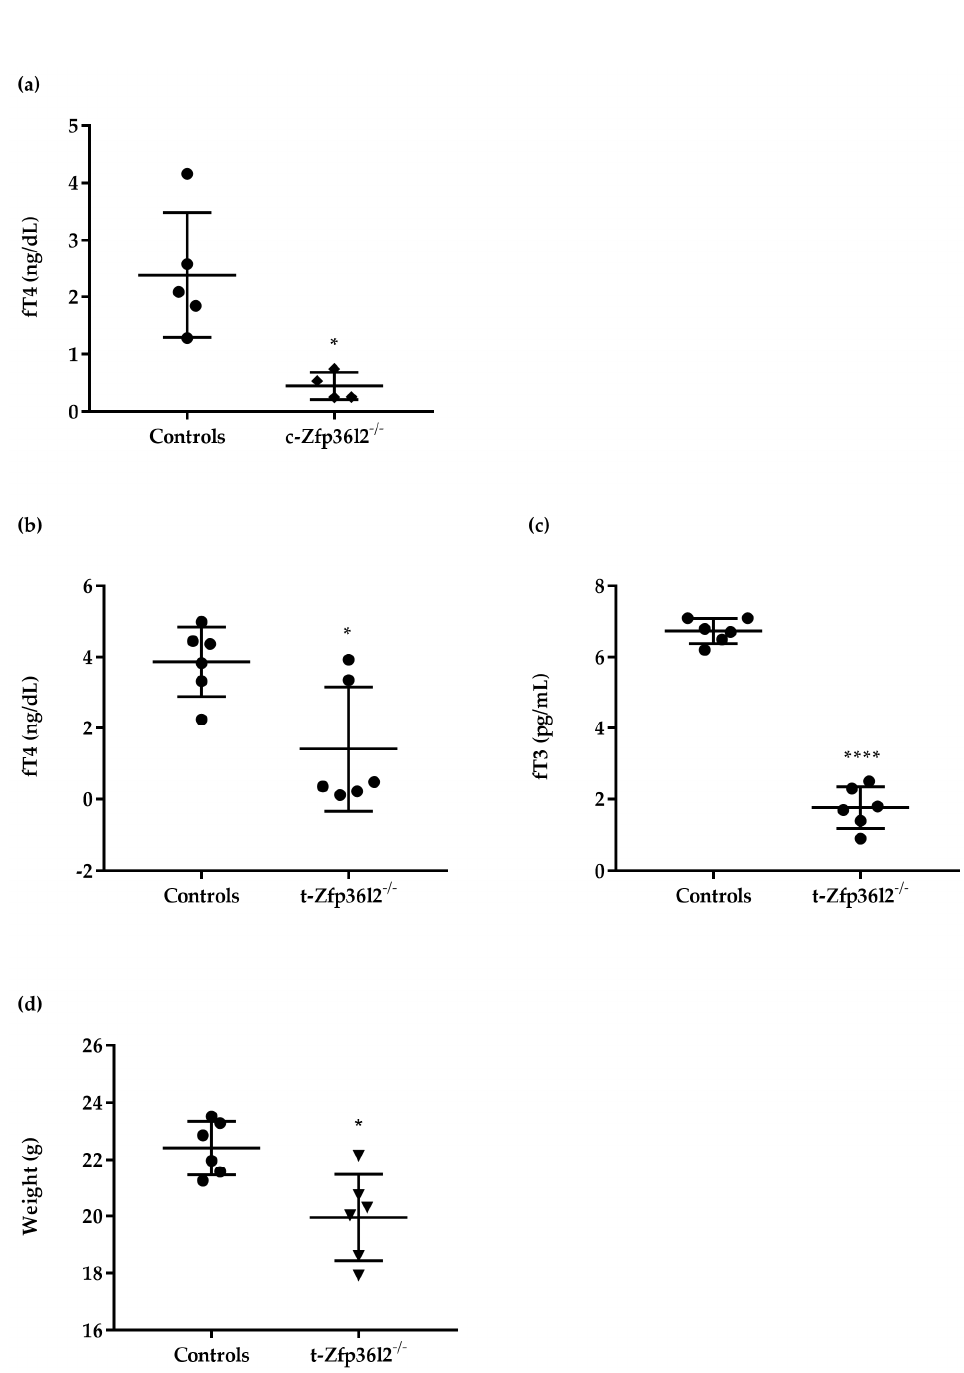
Figure 1. Phenotype of constitutive and thyroid-specific Zfp36l2 -/- mice. The levels of cfT4 were determined by ELISA in blood collected from the controls ( n = 5) and conventional Zfp36l2 -/- ( Zfp36l2 -/- n = 4) female mice at PND 21 ( a ). The levels of cfT4 ( b ) and cfT3 ( c ) were determined by ELISA in blood collected from controls ( n = 6) and t − Zfp36l2 -/- ( n = 6) female mice at the PND 90. Body weight evaluation of the t − Zfp36l2 -/- mice measurements were collected at PND 90 ( d ). Data are reported as mean ± standard deviation * p < 0.05; **** p < 0.0001.